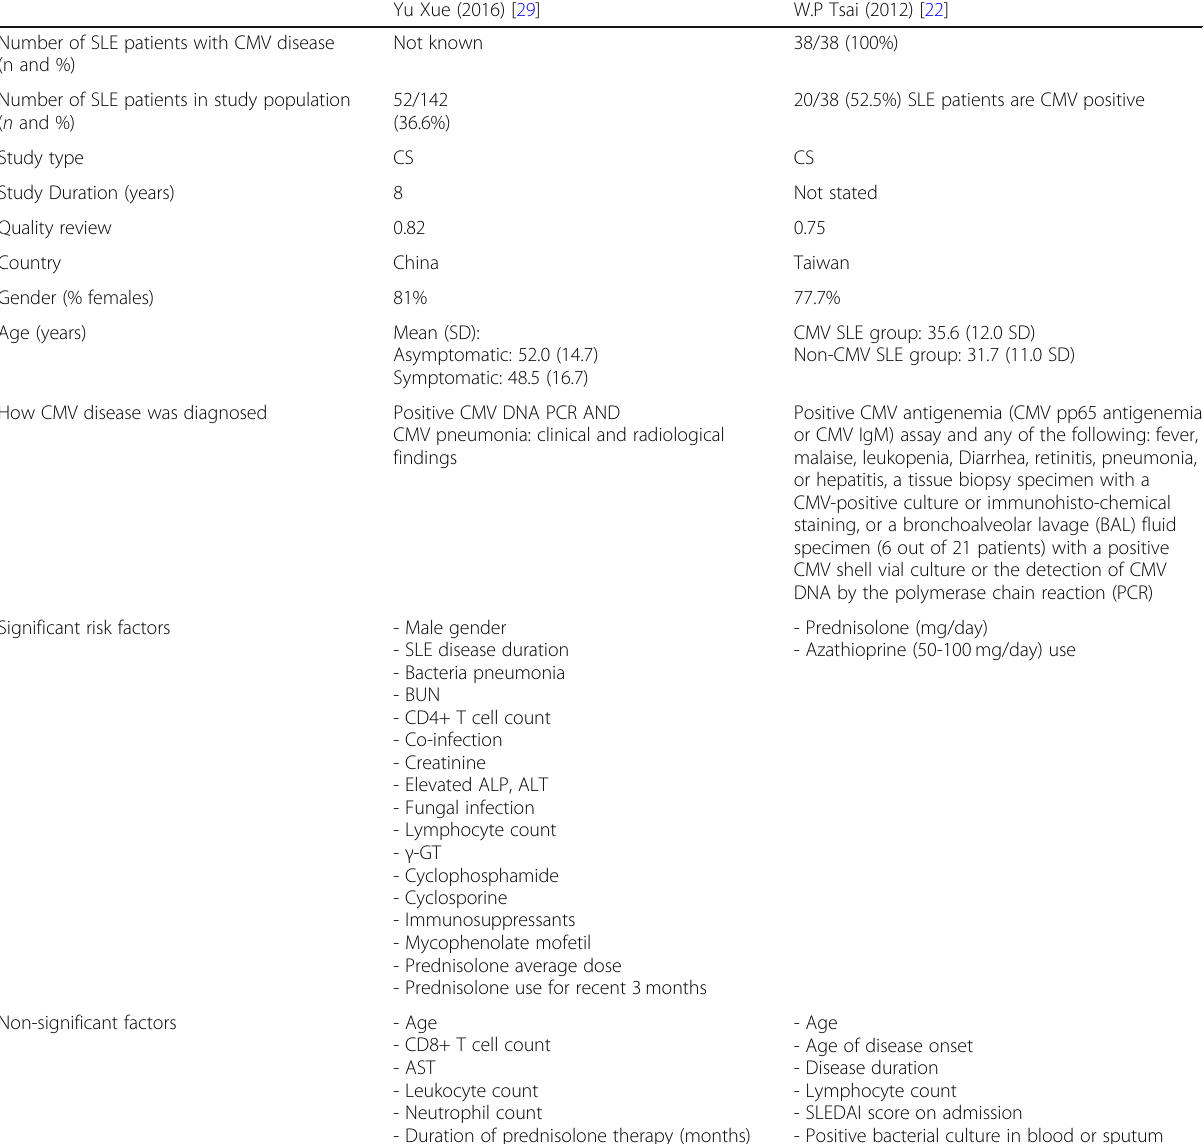
Table 1 Characteristics of studies looking at risk factors for CMV disease in SLE